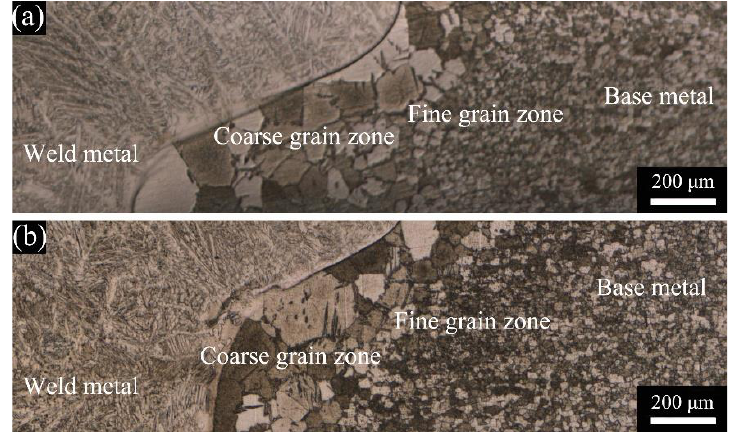
Figure 7. Microstructure of the HAZ: ( a ) without ultrasonic treatment and ( b ) with ultrasonic treatment.